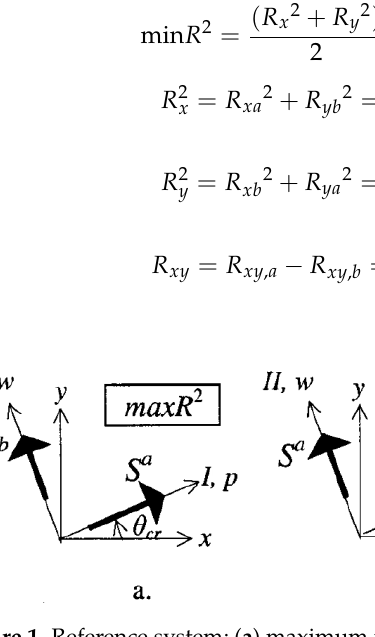
In Equations (10)–(12), ε ij represents the correlation coefficients between the modes i and j . A graphical representation of the reactions calculated using Mohr’s circle is shown in Figure 2.